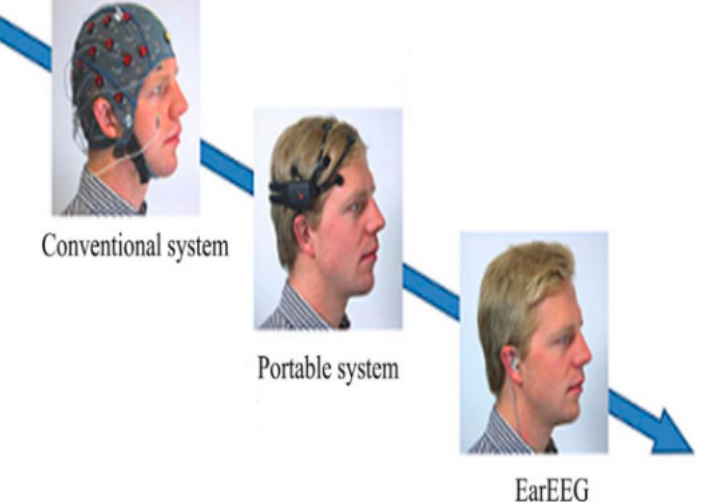
Figure 10. Evolution of EEG from conventional device to in-ear EEG. Reproduced with permission from [166], Elsvier, 2017.